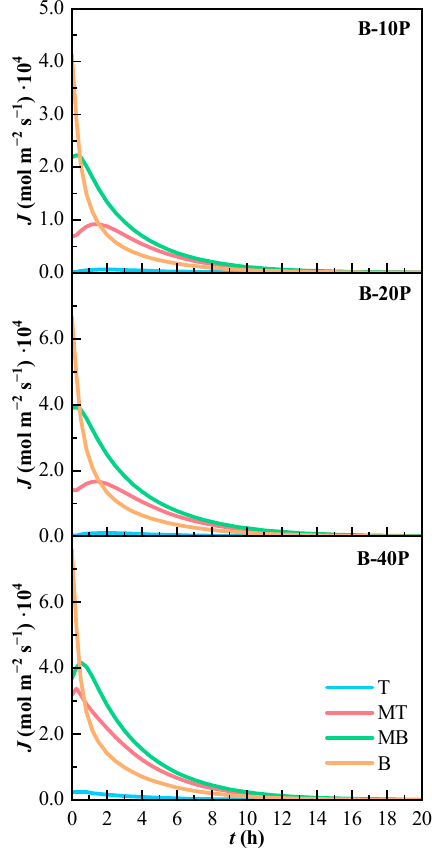
Figure 8. Variation of the estimated molar flux ( J ) of the binary mixtures over time. T (Top), MT (Medium Top), MB (Medium Bottom), and B (Bottom) correspond to the different heights of the measurement lines.